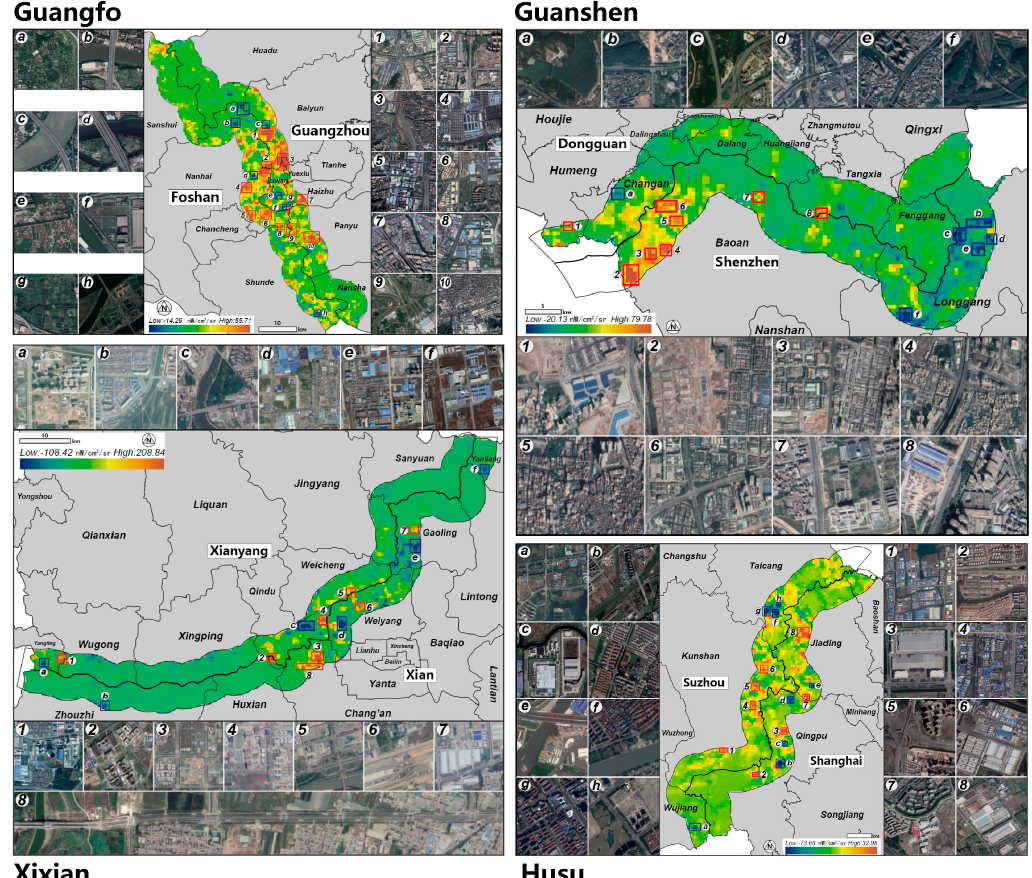
Figure 3. Plots with dramatic lighting changes in the boundary zone and their feature structures. Note: light intensity decreases in plots marked by letters and increases in plots marked by numbers.